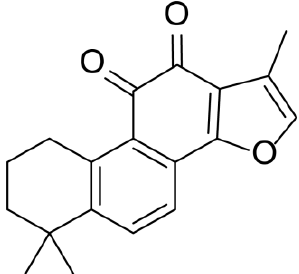
Figure 1. Structure of tanshinone IIA.